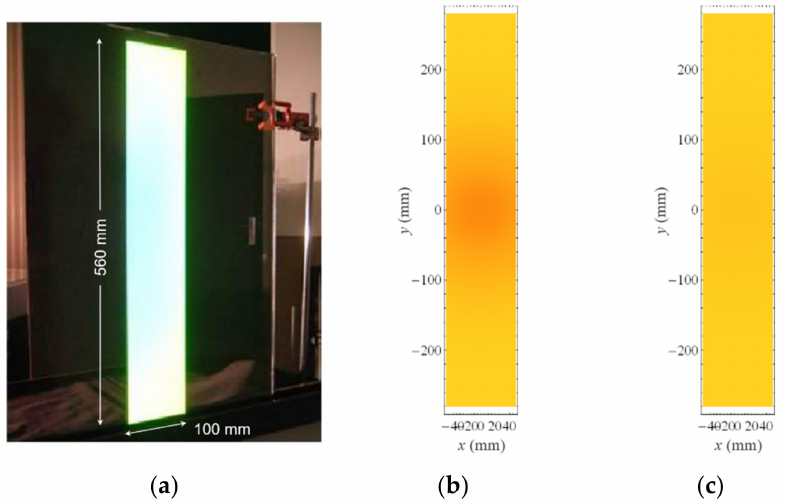
Figure 21. ( a ) diffraction efficiency for the B-HOE recorded on a 3 mm thick glass plate. ( b ) model predictions for a 3 mm thick float glass plate. ( c ) model predictions for a 10 mm thick float glass